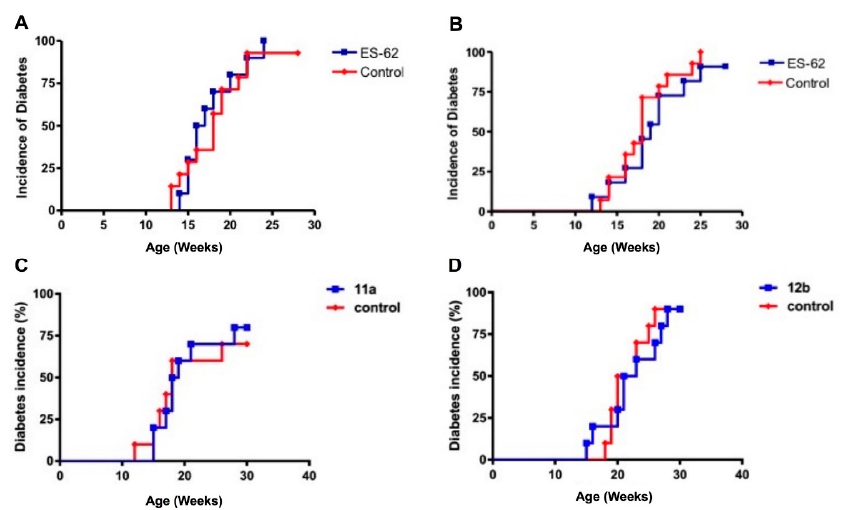
Figure 1. ES-62 and SMAs 11a and 12b do not protect against the development of type 1 diabetes. ( A ) Four-week-old female non-obese diabetic (NOD) mice were injected subcutaneously with 2 µ g of ES-62 ( n = 10) in 200 µ L of sterile PBS once a week between four and 12 weeks of age. Control mice ( n = 13) were injected with 200 µ L of sterile PBS according to the same protocol. ( B ) 9–10 week-old female NOD mice were injected six times subcutaneously with sterile PBS (control) or 10 µ g of ES-62 in sterile PBS over a two-week period ( n = 9). Five-week-old female NOD mice received intraperitoneal injections of PBS (control) or 1 µ g SMA 11a ( C ) or 12b ( D ) twice a week for 10 weeks ( n = 10). The incidence of diabetes was monitored by regularly checking for the presence of glycosuria.